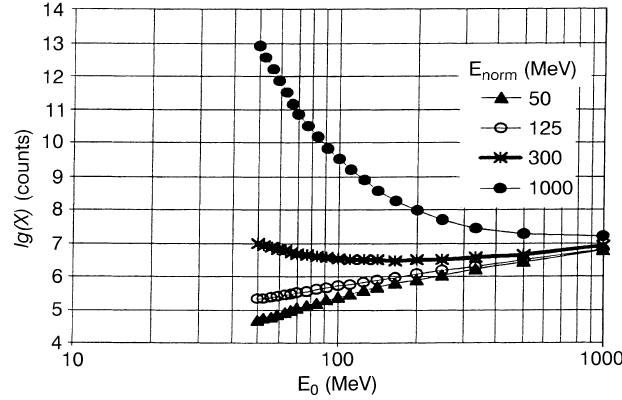
Fig. 7. The logarithmic response of a neutron monitor to solar neutrons for the standard observational conditions (see Sect. 4) as a functionofthecharacteristicenergy E o ofanexponentialsolar-neutron spectrum. The total number of neutrons with energy above E norm injected from the Sun towards the Earth is fixed at 10 30 neutrons/sr. Different curves correspond to different values of E